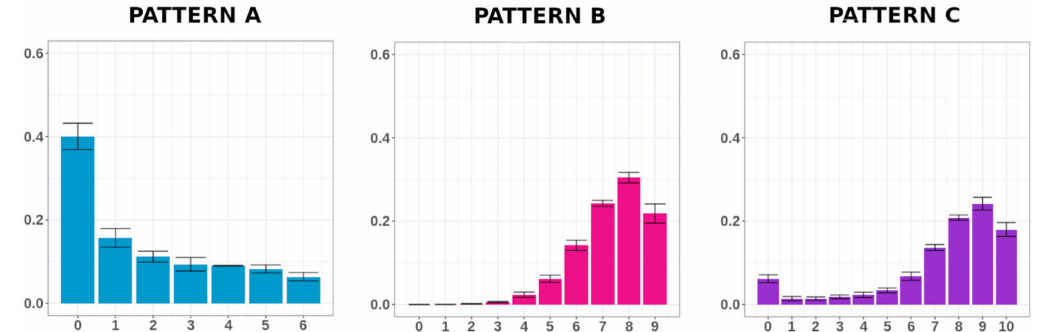
Figure 1. Pattern of methylation class distributions (Dn). Conditions 6, 17 and 1 have been chosen as paradigmatic examples of the Patterns A, B and C, respectively. For each condition, the methylation class (MC) average frequencies and the standard errors are